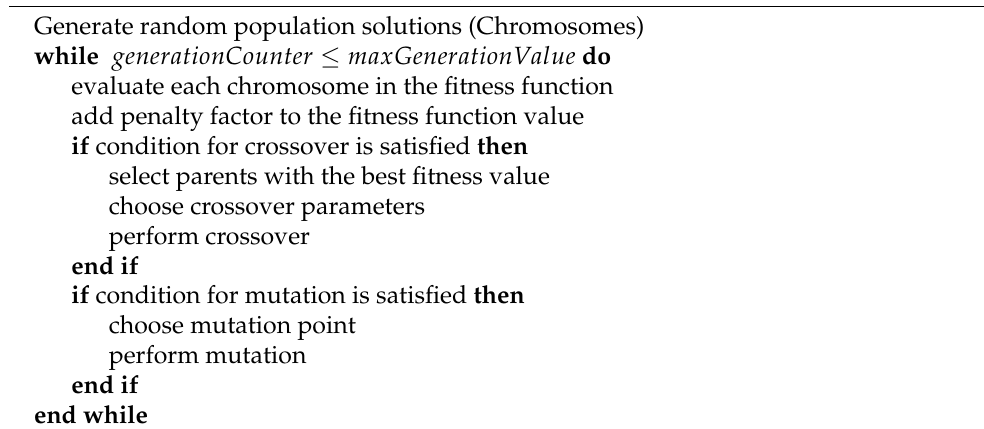
Algorithm 1 Genetic algorithm for heterogeneous